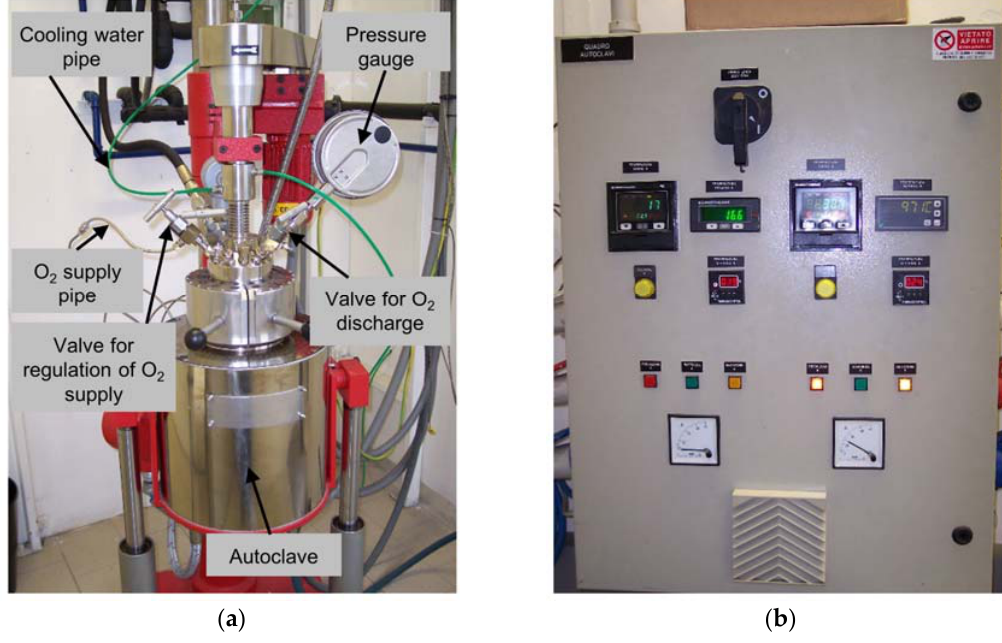
Figure 1. Wet oxidation reactor at lab ‐ scale ( a ) and programmable logic controller (PLC) ( b ).